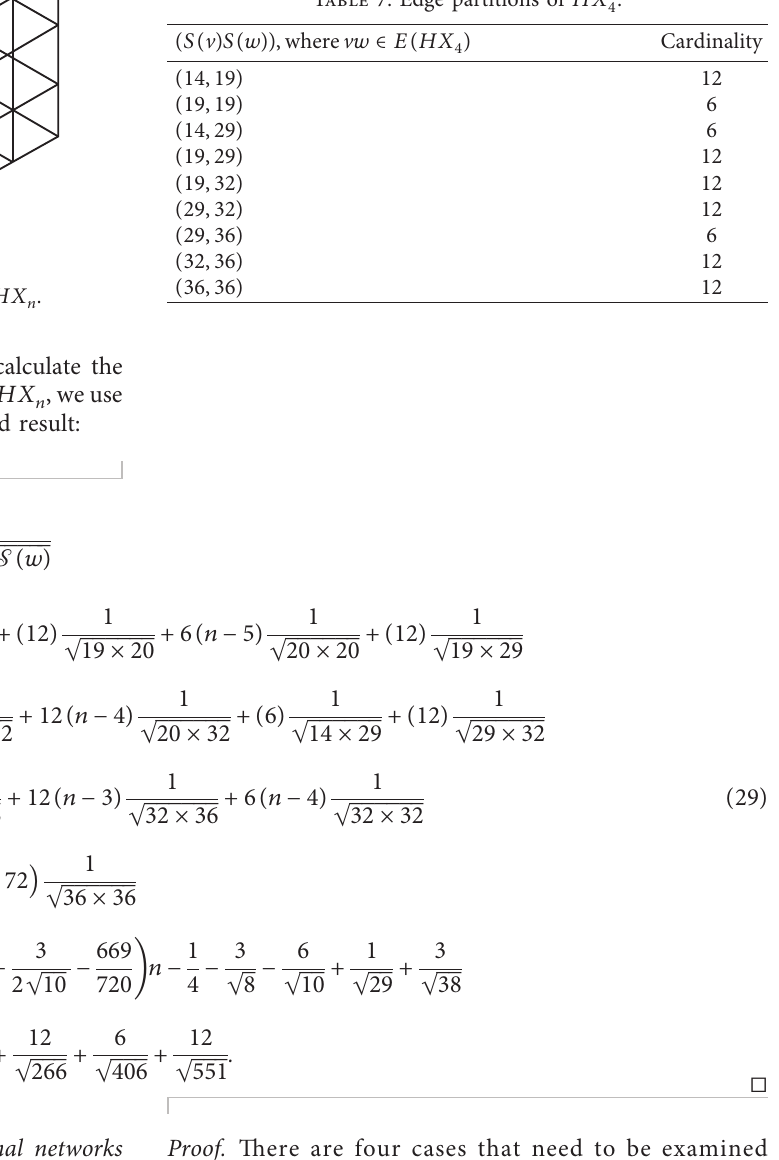
Table 7: Edge partitions of HX